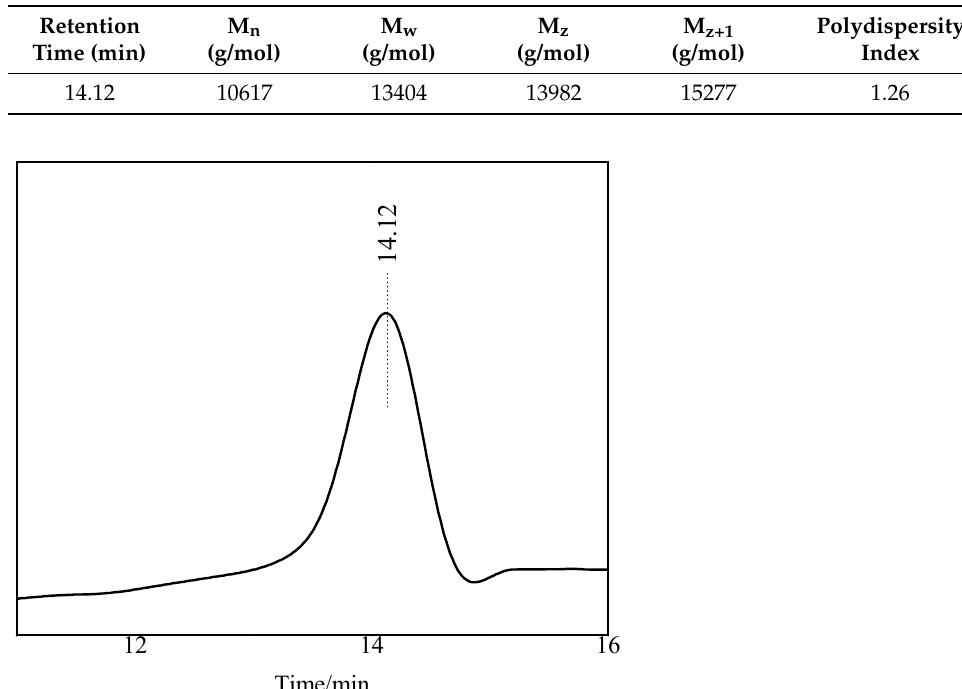
Figure 4. 1 H nuclear magnetic resonance (NMR) spectrum of the polysulfonate dispersant.